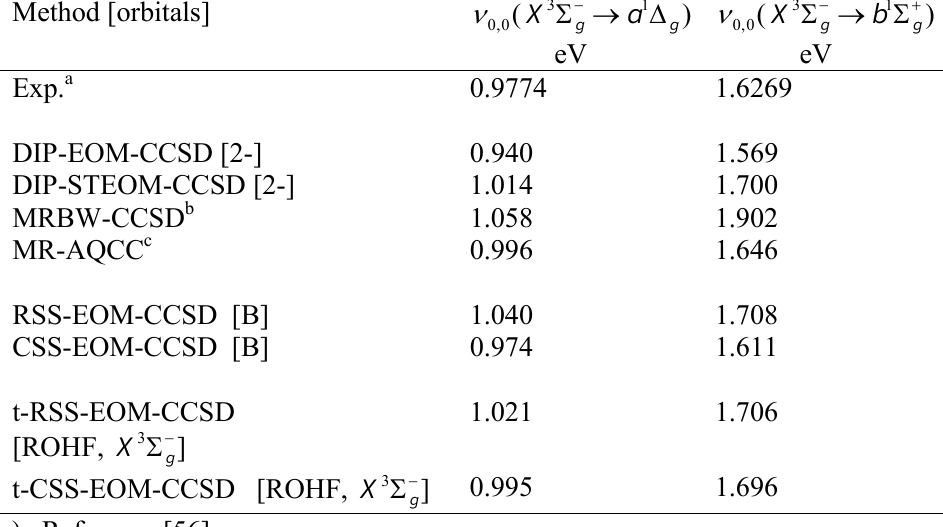
Tabel II. Computed 0-0 transitions for the O Method [orbitals] ν